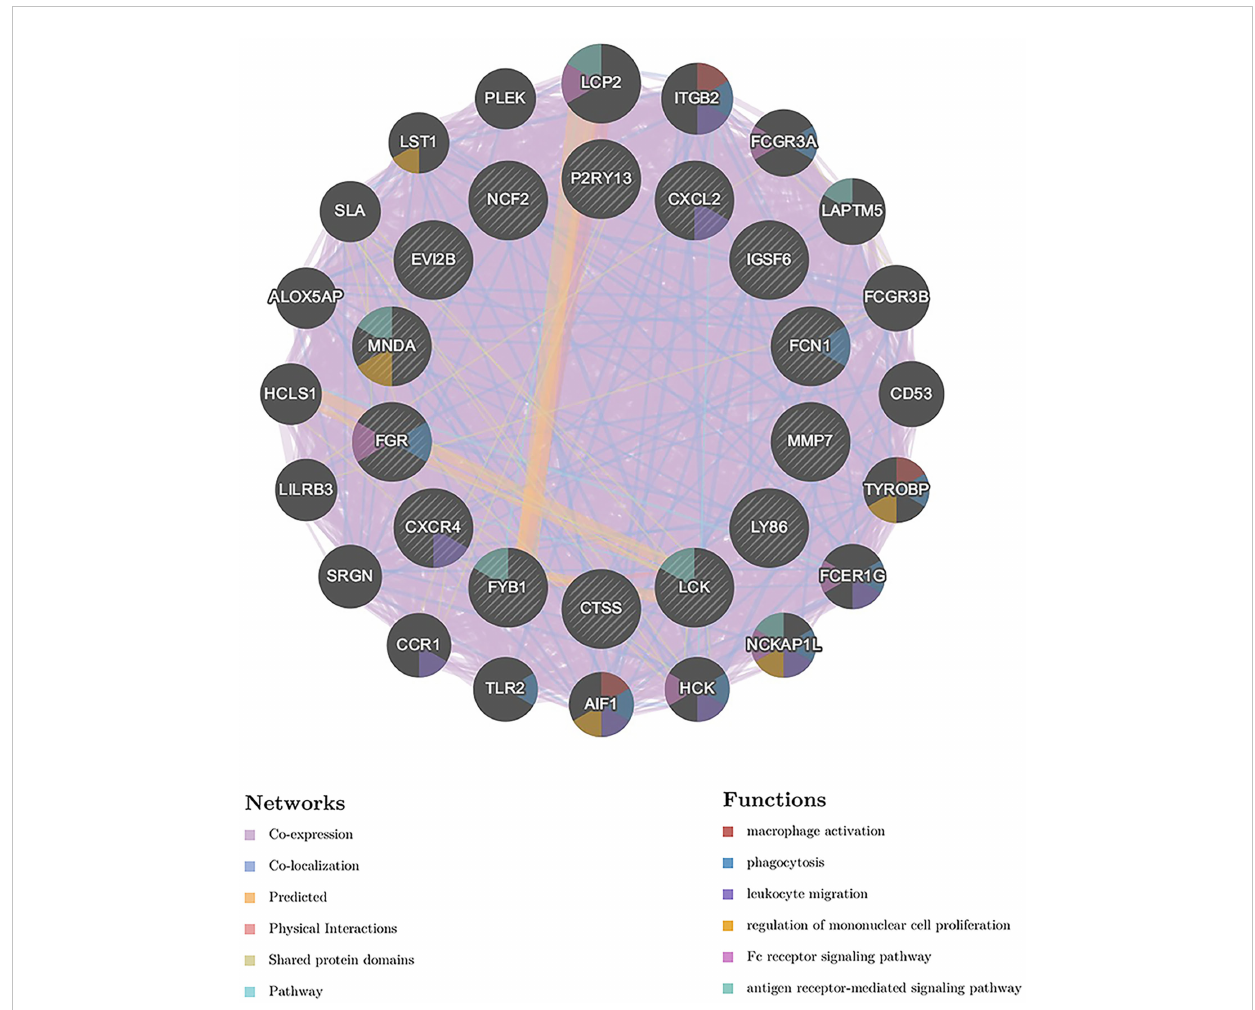
FIGURE 6 GeneMANIA analysis of the hub genes. The biological functions of the genes are shown. The hub genes are located in the inner circle and the genes correlated with the hub genes are located in the outer